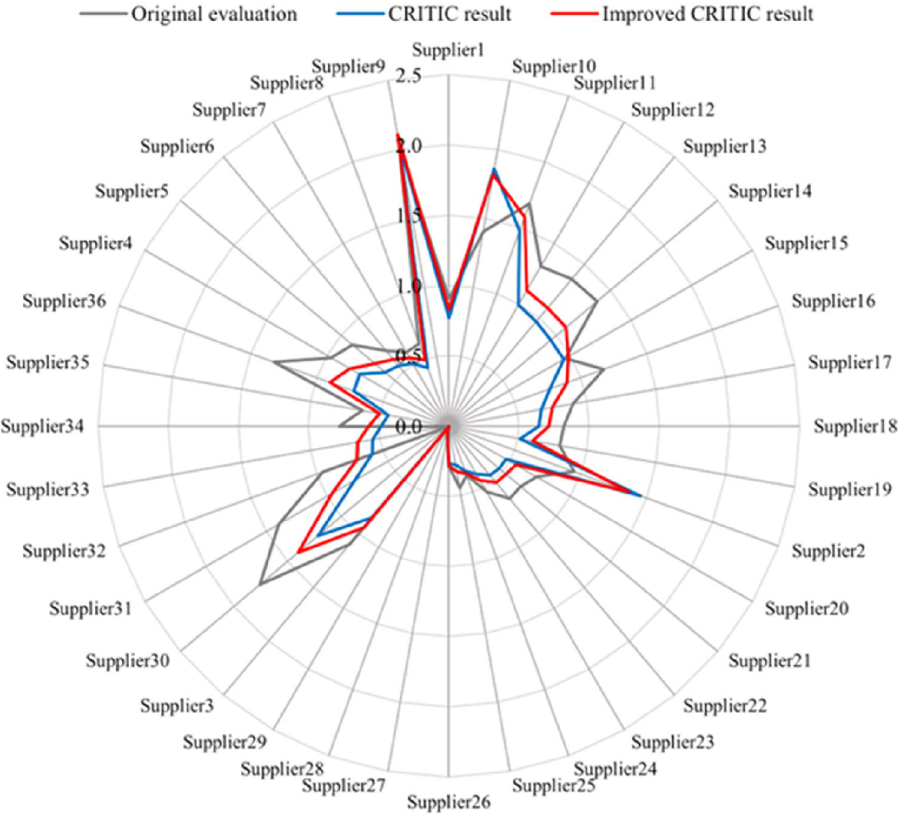
Figure 6. The result of different weighting methods.